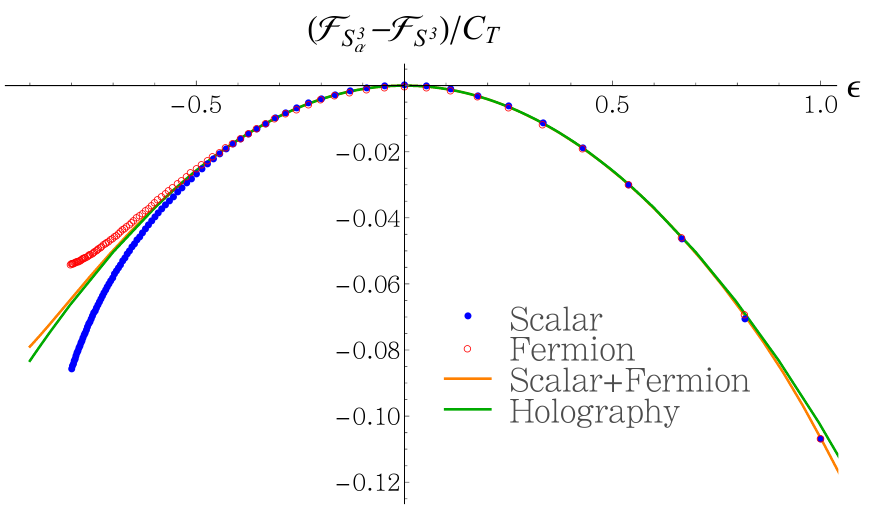
Figure 4 . The normalized free energy ( F (cid:15) in the range (cid:15) 2 [ (cid:0) 1 ; 1] for holographic theories dual to Einstein gravity (green solid line), a free scalar (blue dots), a free fermion (red dots) and the combination of both (orange solid line). The holographic curve is the parabola in